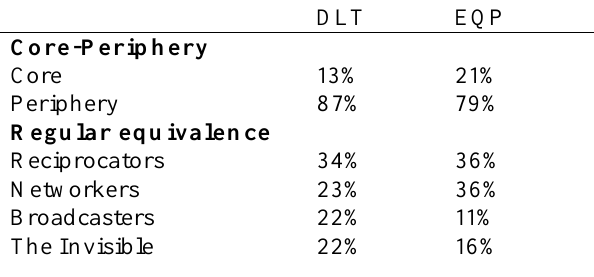
Percentages of Educators in CORR and REGE Partitions